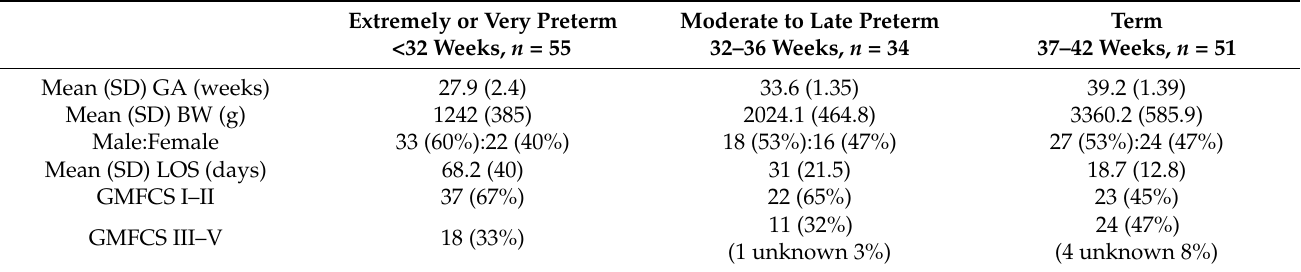
Table 1. Demographic and clinical details. BW = birth weight, GA = Gestational age, LOS = Length of